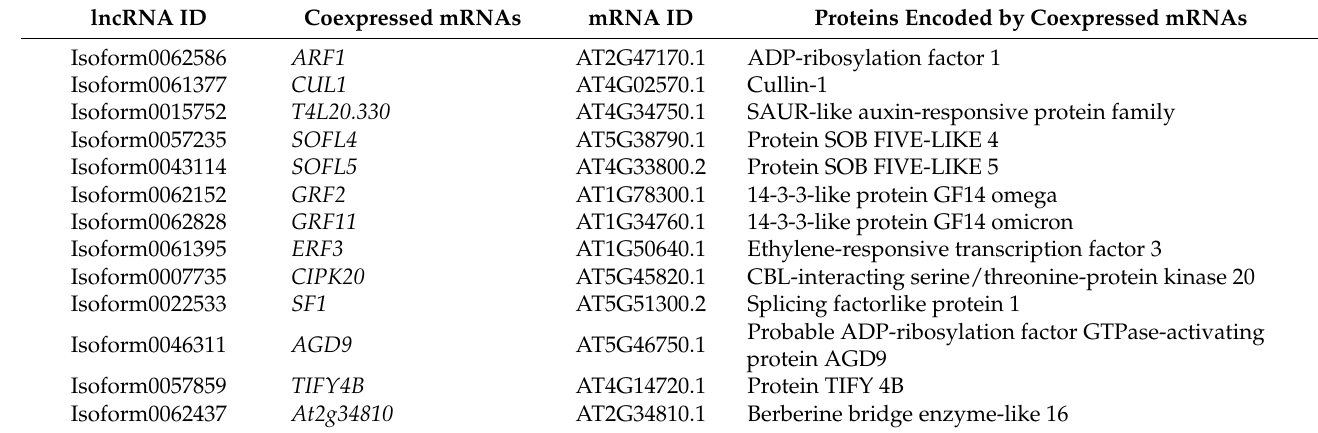
ceptor signaling (Table S6). The expression levels of eight representative coexpressed (Table S6). The expression levels of eight representative coexpressed mRNAs associated mRNAs associated with hormone signaling were confirmed by qRT-PCR, with three with hormone signaling were confirmed by qRT-PCR, with three mRNAs ( ARF1 , CUL1 , mRNAs ( ARF1 , CUL1 , and GRF11 ) showing up-regulation at T2 vs. T1 and T3 vs. T1 , and GRF11 ) showing up-regulation at T2 vs. T1 and T3 vs. T1, and four mRNAs ( ARF1 , and four mRNAs ( ARF1 , SOFL4 , GRF2 , and ERF3 ) showing lower levels at T2 vs. T1 SOFL4 , GRF2 , and ERF3 ) showing lower levels at T2 vs. T1 than T3 vs. T1 (Figure 6). than T3 vs. T1 (Figure 6). Table 6. Thirteen lncRNAs directly linked with hormone